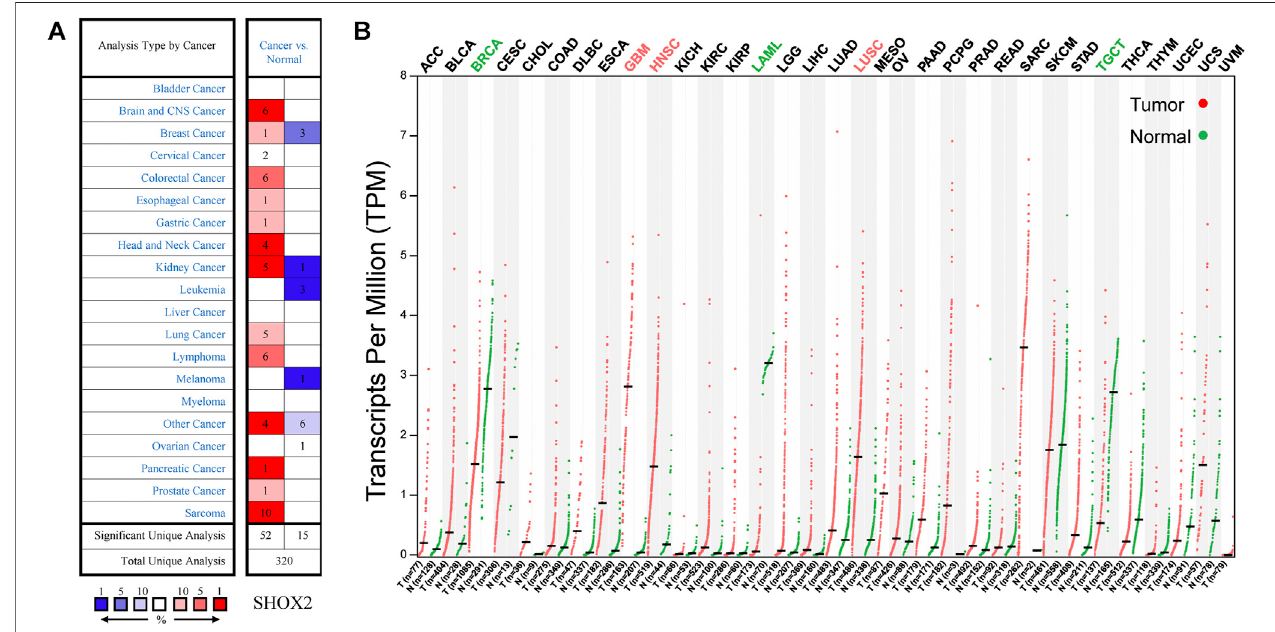
FIGURE 1 | SHOX2 mRNA expression in multiple cancers. (A) The number of datasets with SHOX2 mRNA differential expression between tumor tissues and normal tissues. The left column (red) represents overexpression, and the right column (blue) represents downexpression. This visualized graphic is available from Oncomine, and the threshold parameters were set as follows: p -value (cid:1) 0.05, fold change (cid:1) 2, all gene rankings, and mRNA data type. (B) SHOX2 gene expression pro fi le in various tumor samples and normal samples by GEPIA. SHOX2 : short stature homeobox 2; GEPIA: gene expression pro fi ling interactive